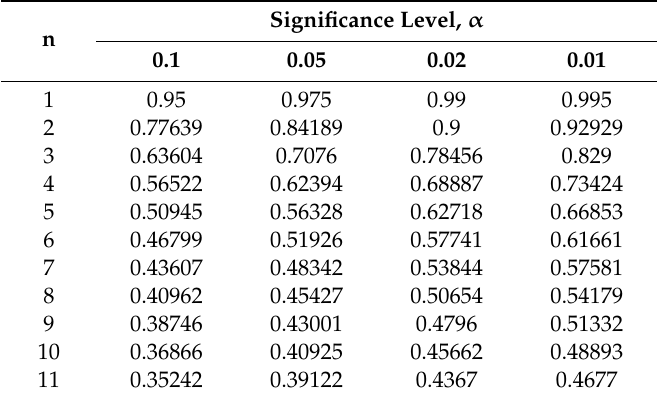
Table A1. Critical values ( D α n ) of the maximum absolute di ff erence between observed and expected frequencies